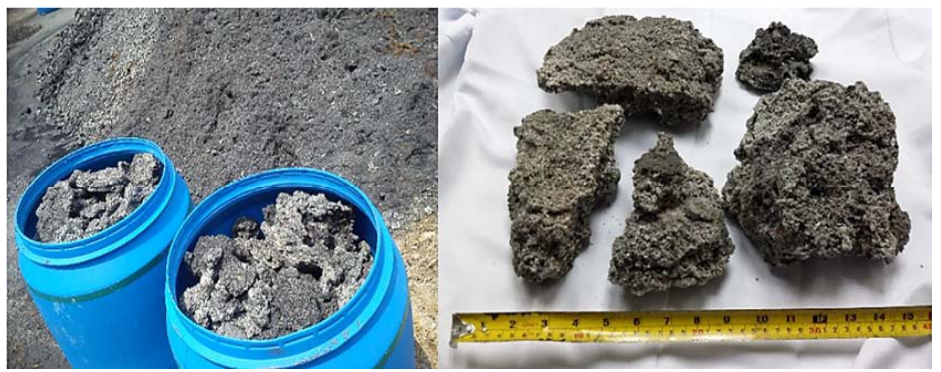
Figure 2. Raw POC collected from palm oil mill.